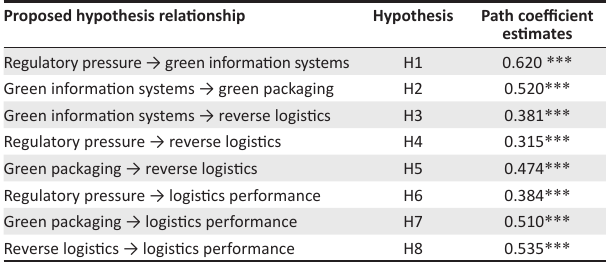
TABLE 3: Model fit results (confirmatory factor analysis). TABLE 5: Results of hypotheses testing (path